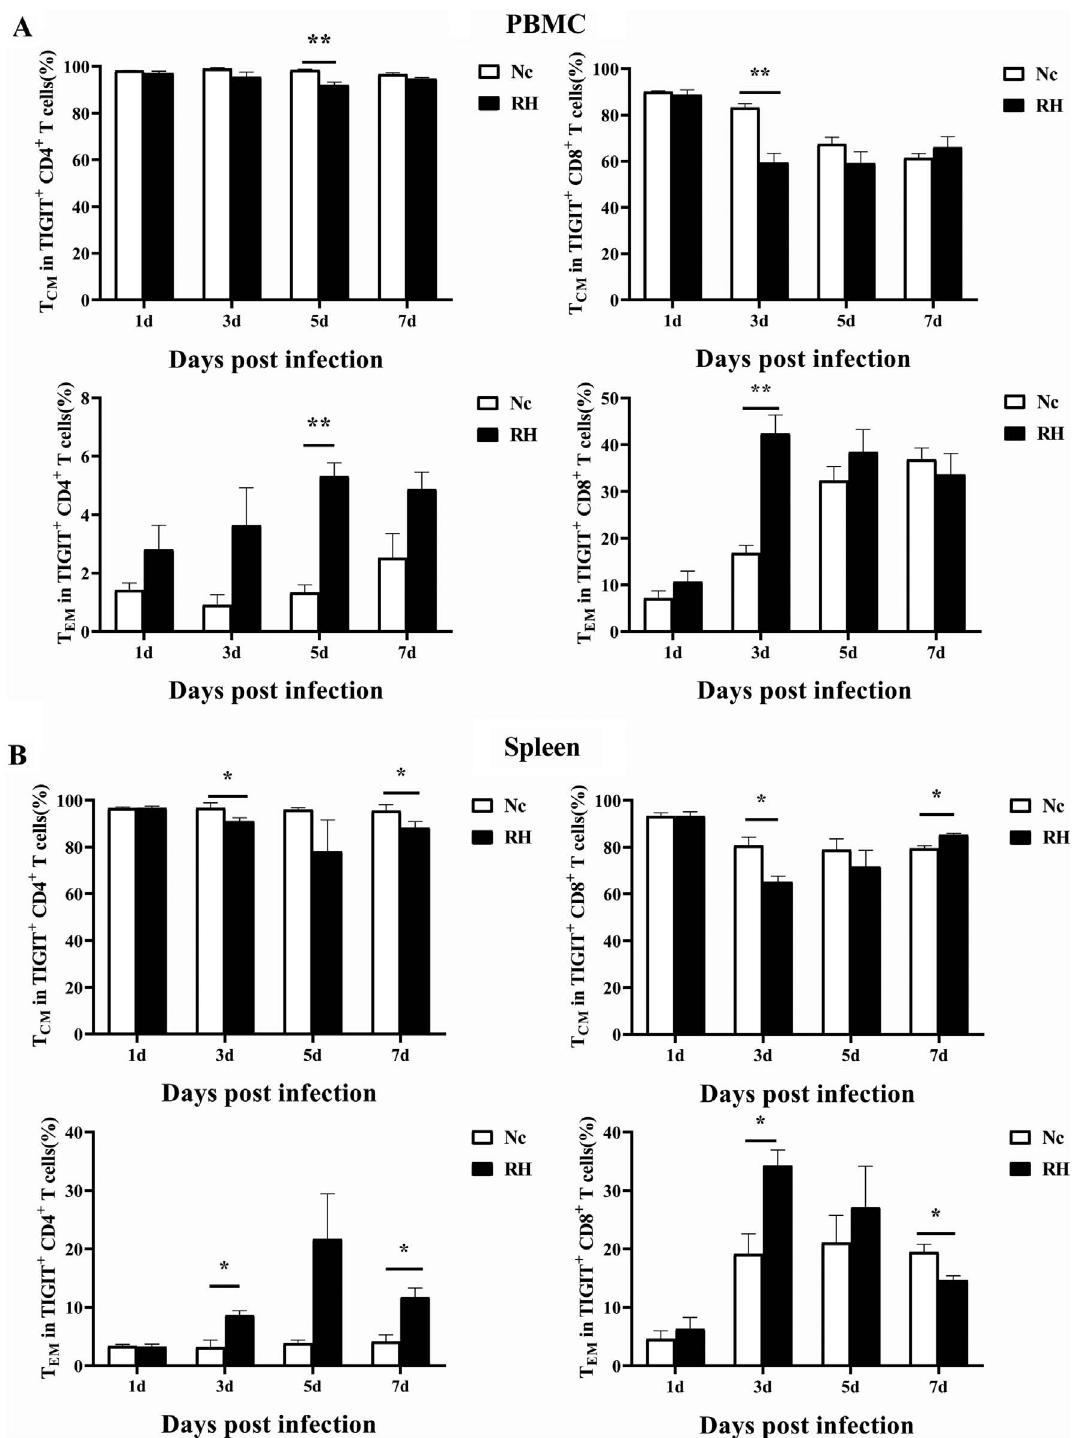
Figure 3. Relative contributions of memory T cell subsets of TIGIT + T cells after T. gondii infection. (A) Dynamic changes in memory T cell subsets of TIGIT + T cell in PBMCs at different time points following RH infection. (B) Dynamic changes in memory T cell subsets of TIGIT + T cells in the spleen at different time points following RH infection. The results are representative of three independent experiments with fi ve mice in each group per experiment, with data denoting means ±